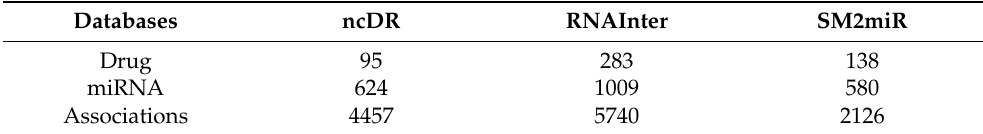
Table 1. The statistics of miRNAs, SMs and SM–miRNA association in three datasets.